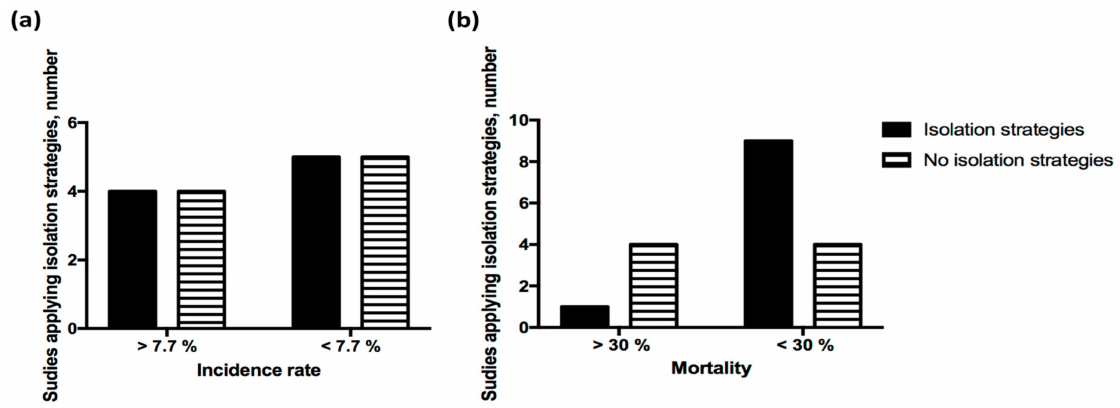
Figure 5. Impact of use of isolation strategies on the outcome of COVID-19 infection in HD patients. The impacts of applying isolation strategies at HD facilities on the ( a ) incidence ( p = 1.0) and ( b ) mortality ( p = 0.088) of COVID-19 was not significant. p value between groups by using Fisher’s exact